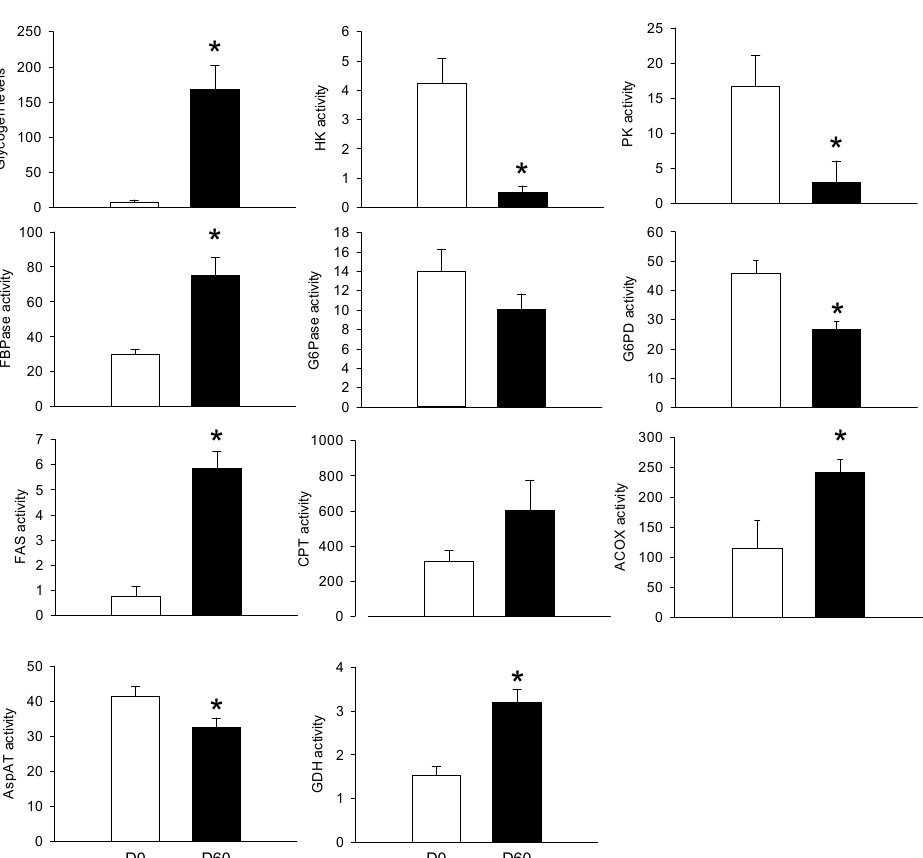
Figure 6. Glycogen levels, hexokinase (HK), pyruvate kinase (PK), fructose 1,6-biphosphatase (FBPase), glucose 6-phosphatase (G6Pase), glucose 6-phosphate dehydrogenase (G6PD), fatty acid synthase (FAS), carnitine palmitoyltransferase (CPT), acyl-CoA oxoxidase (ACOX), aspartate transaminase (AspAT), and glutamate dehydrogenase (GDH) activities in liver samples from Yucatan mini-pigs fed a high fat–high sucrose (HFHS) diet for 2 months. Enzyme activity units (mU) are defined as nmol of substrate converted to product, per min, at 37 °C and per mg protein. Glycogen levels are expressed in μ mol of glycosyl units/g wet tissue. Results are expressed as means + SEM ( n = 5) and were analysed using a t-student test. *, significantly different from the D0 ( p < 0.05).